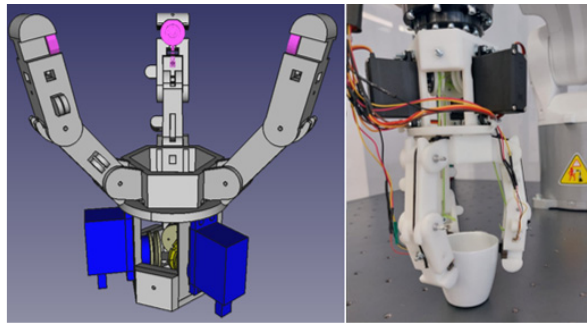
Figure 10. Three-toed model and gripper. Source: (own).